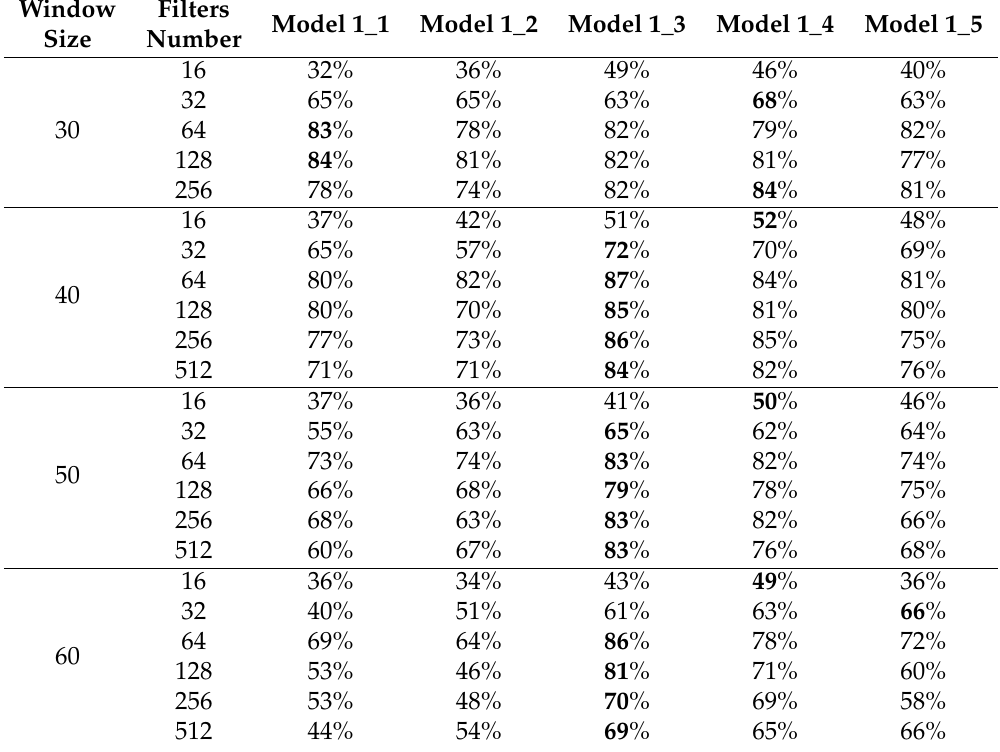
Table 3. The accuracy of five models for Experiment 1 using different window sizes and filter numbers.